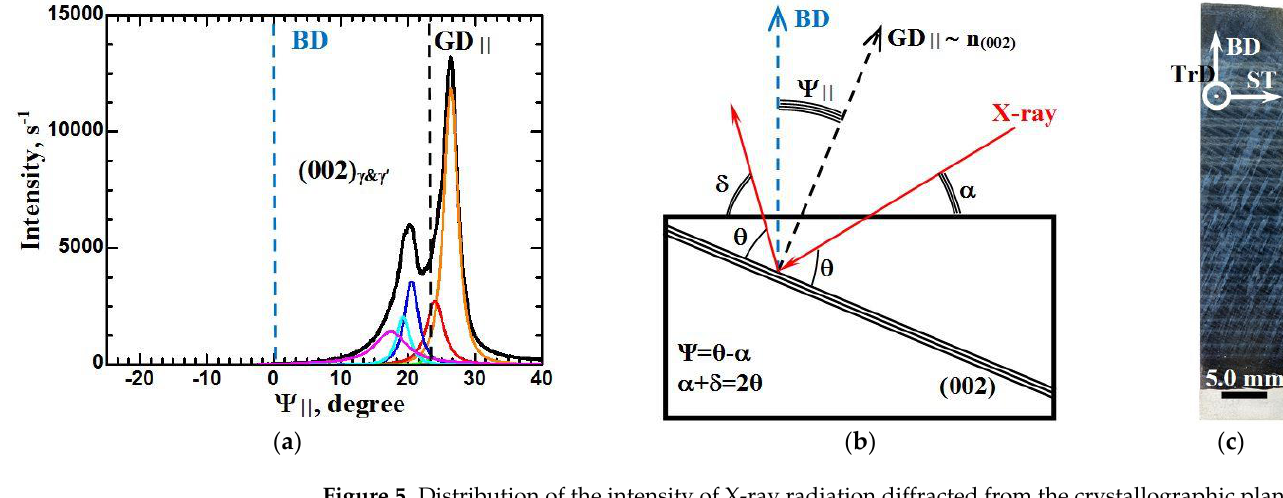
Figure 5. Distribution of the intensity of X-ray radiation diffracted from the crystallographic planes (002) γ - and γ’ -phase as a function of the rocking angle relative to the BD ( a ), X-ray imaging scheme ( b ), and image of the macrostructure ( c ) in a section perpendicular to the TrD.